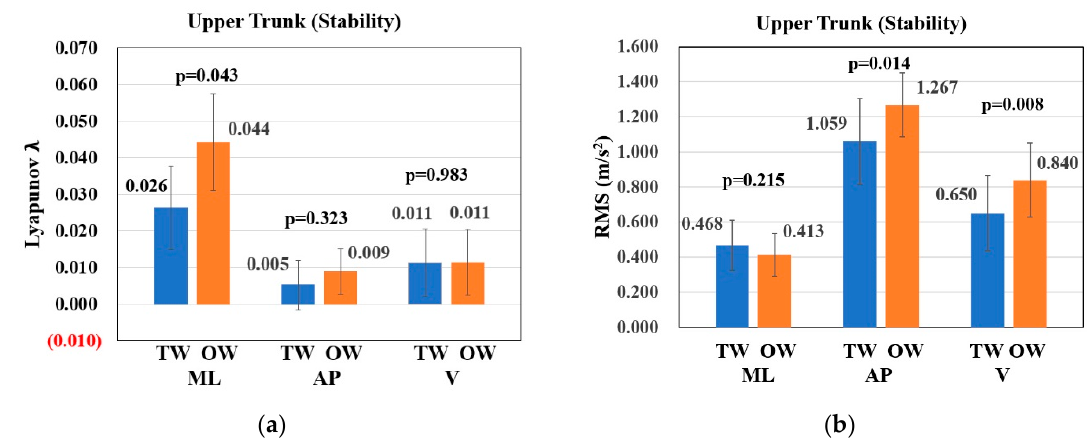
( c ) Figure 4. Comparison of gait features between TW and OW condition: ( a ) Sample entropy of foot acceleration during swing phase in V direction. ( b ) The RMS of foot acceleration during swing phase in V direction. ( c ) The maximal Lyapunov exponent of COP position during stance phase in ML and AP directions. Under two conditions (as shown in Figure 5), the movement degree and regularity of upper trunk are very similar. It means that the treadmill does not change the kinematic characteristics of